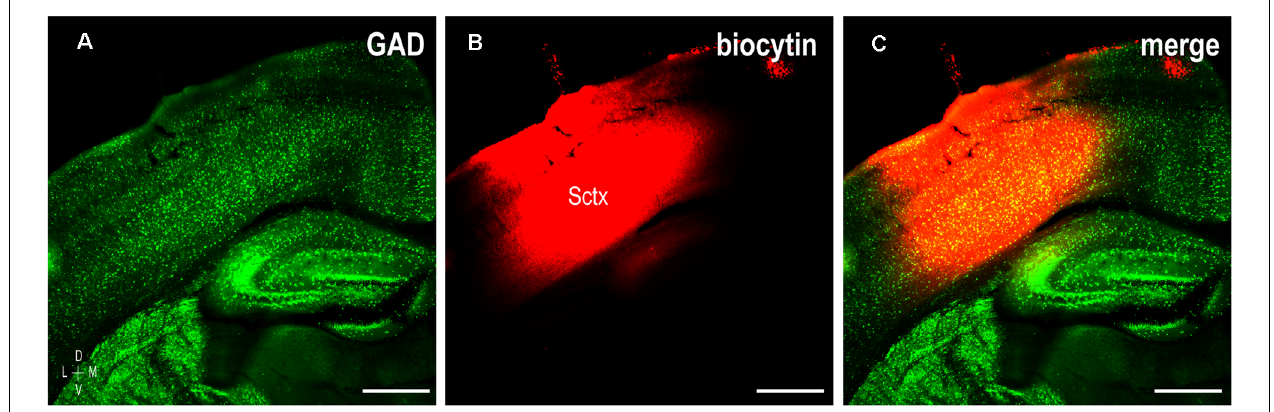
FIGURE 1 | Representative tracer placement labeling somatosensory corticocollicular projections in a P12 mouse. GAD labeling ( A , green) and biocytin crystal placement ( B , red) encompassing deep output layers of somatosensory cortex (Sctx, C , merge). Scale bars = 500 µ m.